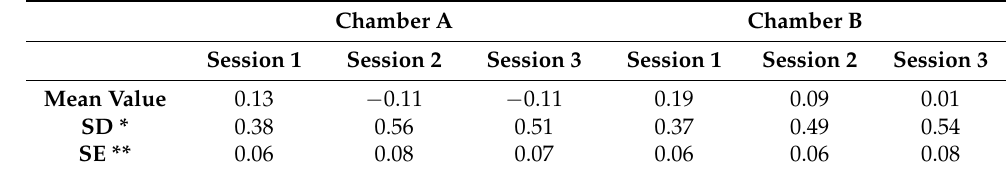
Table 4. Acceptability assessment.